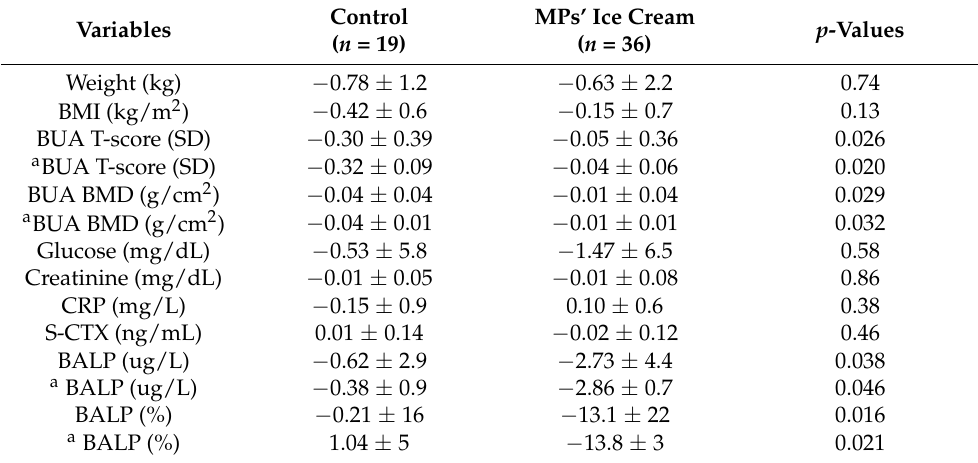
Table 2. Changes in participants’ characteristics at follow-up according to intervention.